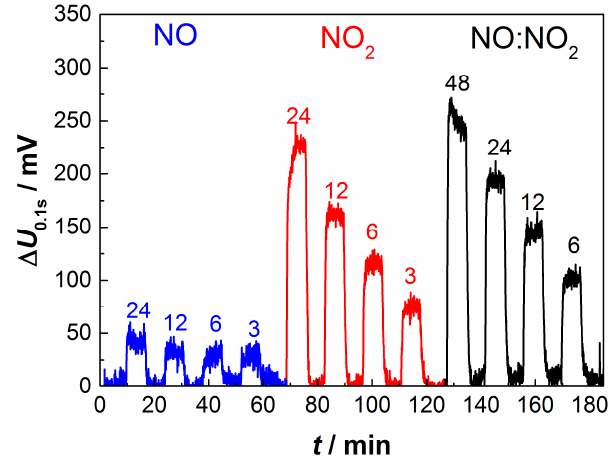
Figure 8. Sensor output voltage Δ U 0.1s at NO and NO 2 concentrations between 24 ppm and 3 ppm, and NO:NO 2 (1:1) mixtures between 48 ppm and 6 ppm, respectively, after single sign pulses. The